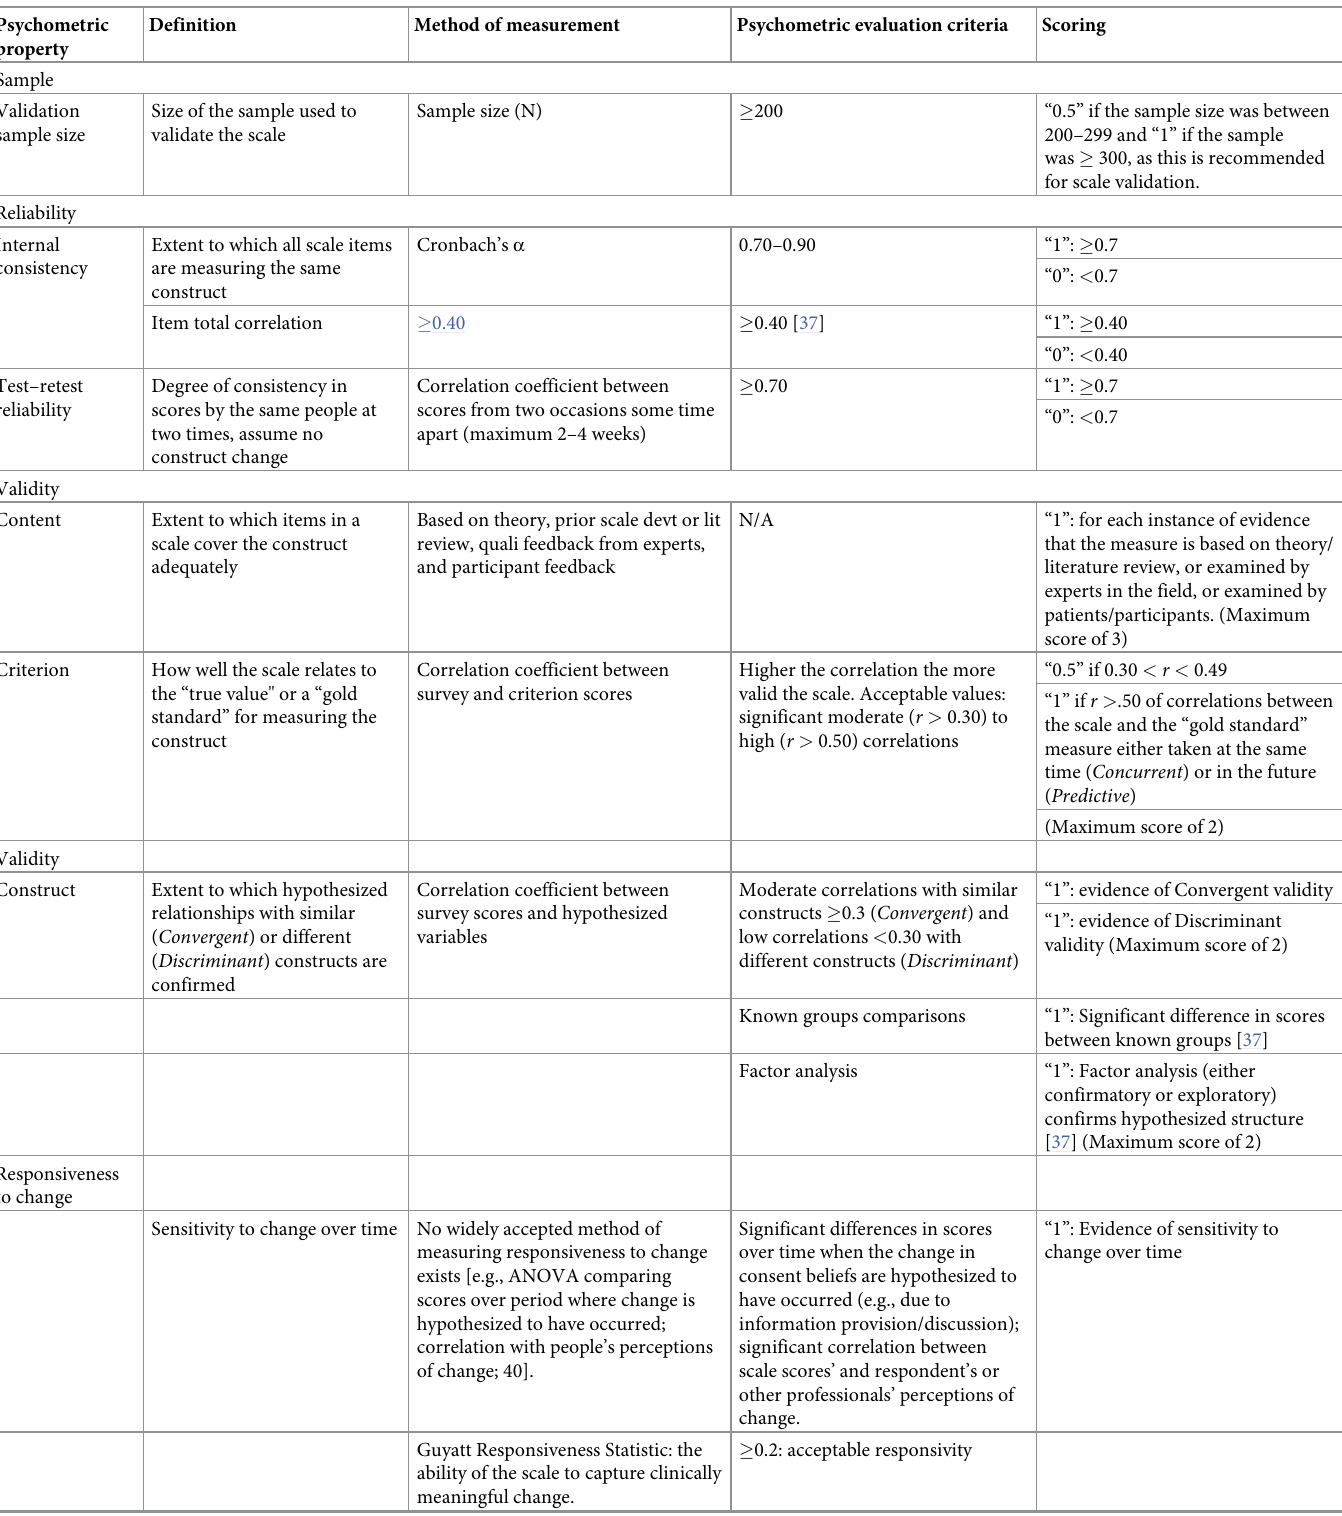
Table 2. Psychometric properties of scales and rules for